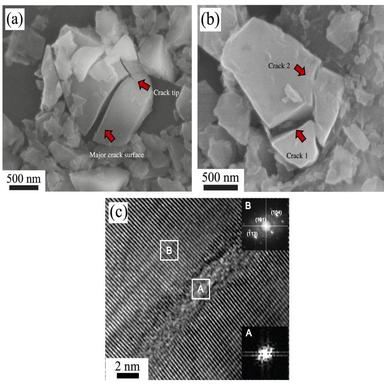
Microstructure characterization of deformed particles: (a) and (b) are two representative SEM micrographs of fractured particles from shot 10; (c) HRTEM image from impacted particle from shot 09 shows lattice columns on either side of the band corresponding to the direction of crystalline boron carbide, but there is a loss of periodicity within the band indicating localized amorphization. Insets show FFT patterns further concluding the presence of an amorphous band within a crystalline phase of boron carb